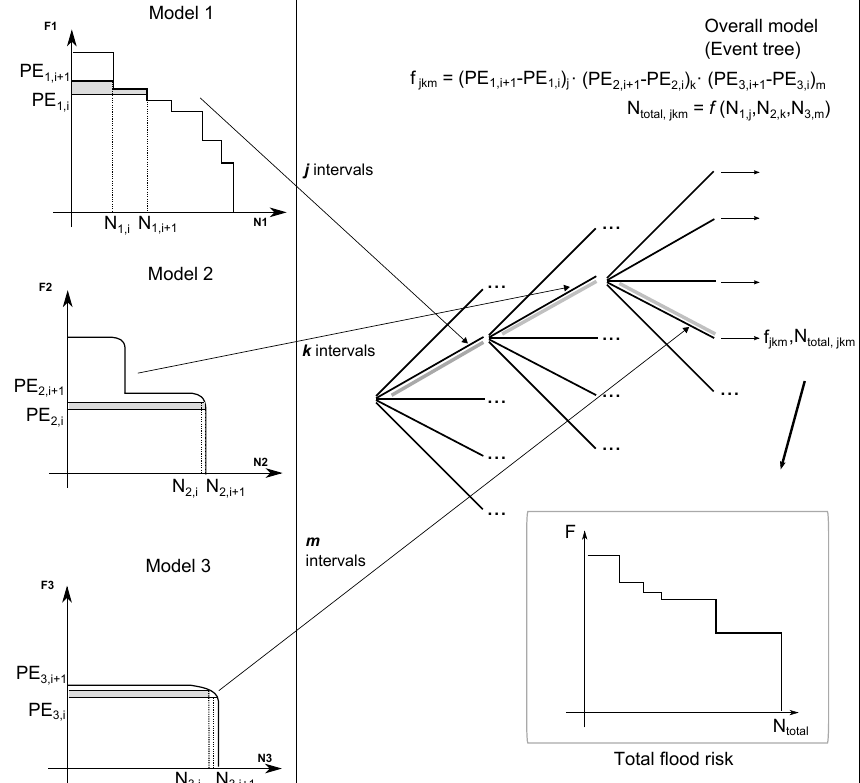
Fig. 5. Combination of outcomes of different risk